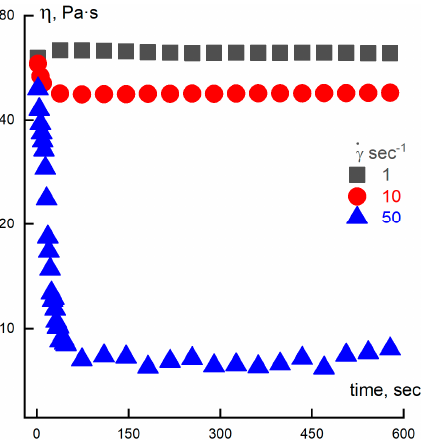
Figure 7. Evolution of the viscosity of the test emulsion with 5% of PDMS-100, measured at different shear rates.